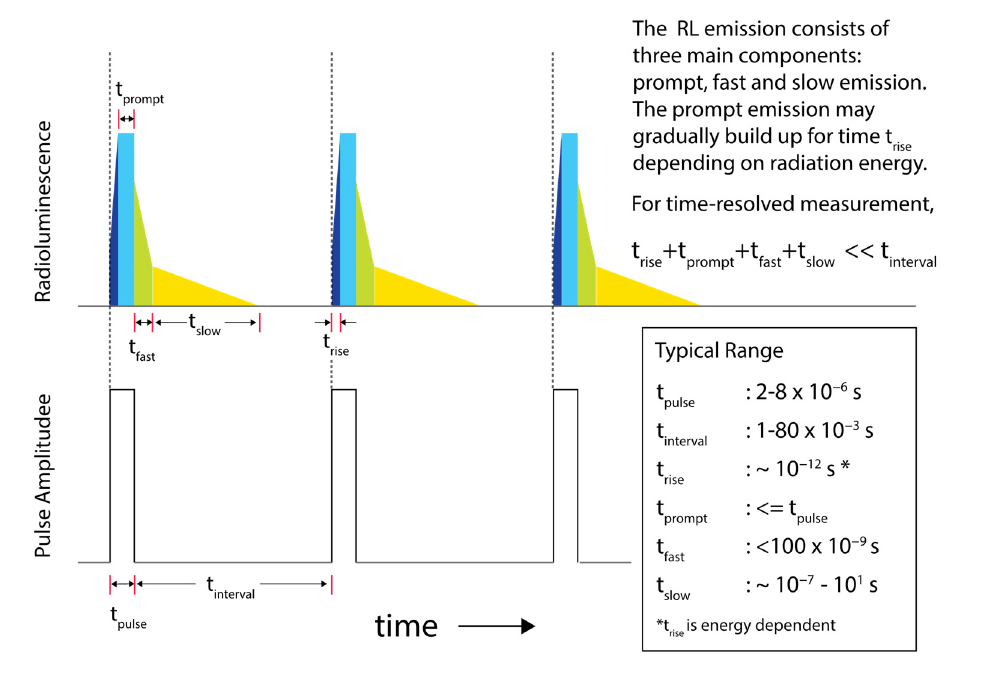
Figure 1. Diagram of time-resolved scintillation signal with general shape and timing characteristics, shown against corresponding linac pulses.